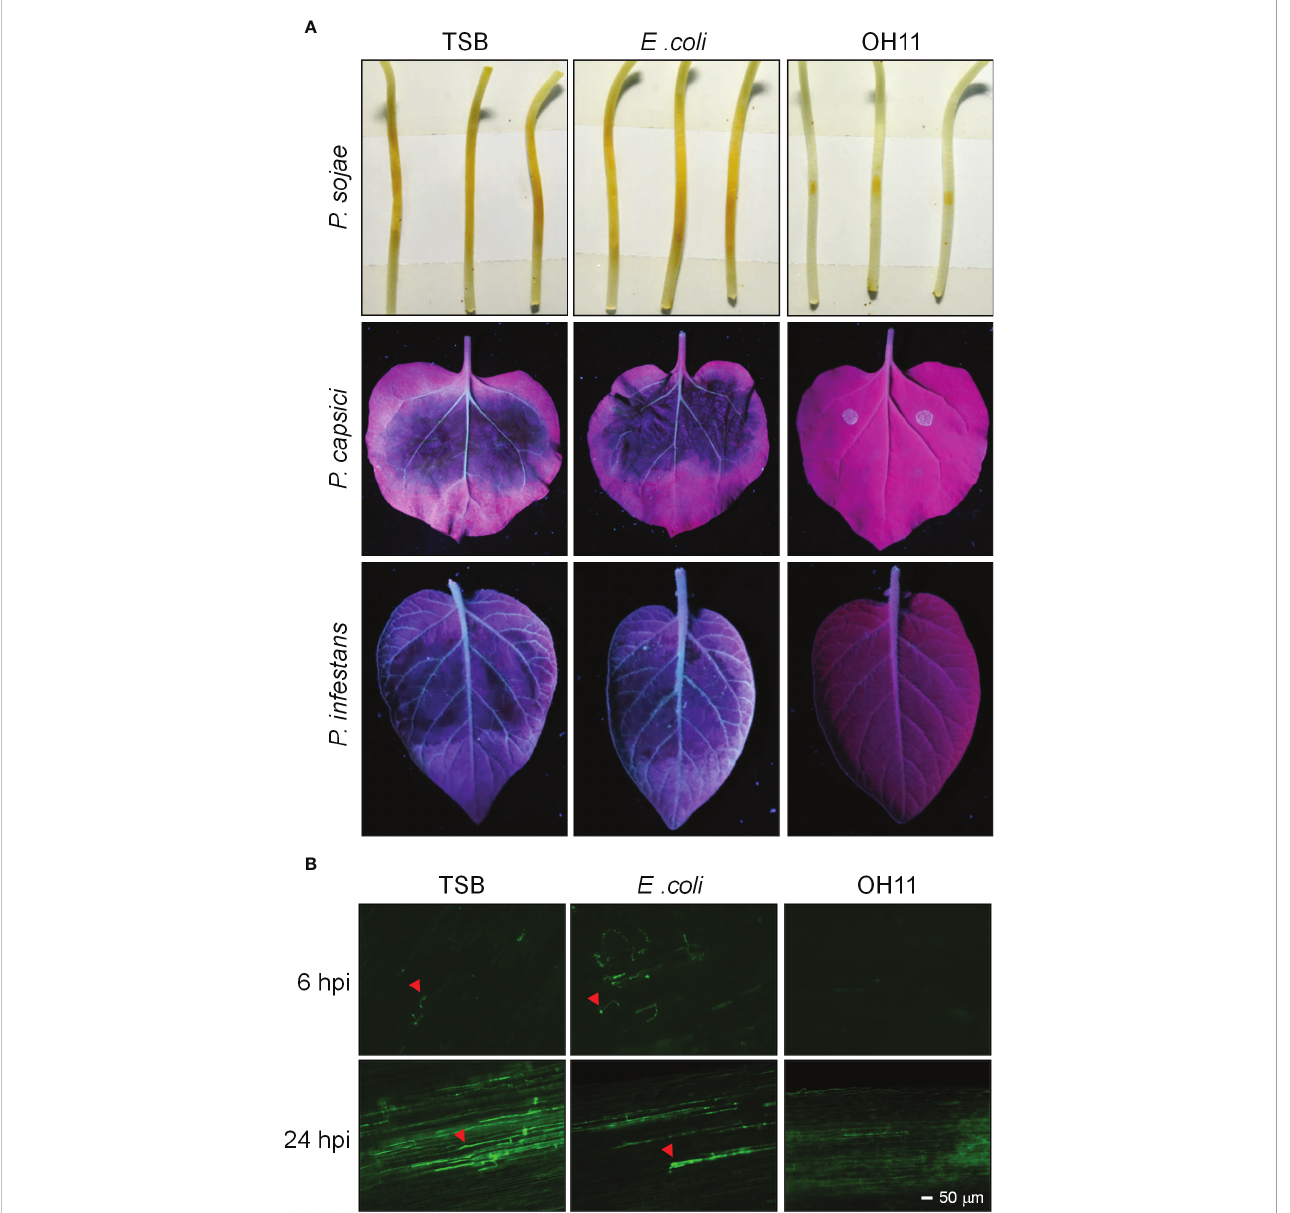
FIGURE 1 L. enzymogenes OH11 inhibited the virulence of Phytophthora . (A) OH11 inhibited the virulence of P. sojae , P. capsici and P. infestans. A total of 200 Phytophthora zoospores were mixed with an equal volume of TSB media, bacterial cultures of E coli and OH11, individually. The mixtures were inoculated onto host plants (soybean, N. benthamiana , or potato). TSB- and E. coli -treated Phytophthora had obvious lesions on host plants, while OH11- treated Phytophthora revealed no lesion. (B) OH11 inhibited infection of GFP-labeled P. sojae zoospores. At 6 hpi, TSB- and E coli -treated P. sojae showed germinated cysts that could ef fi ciently infect soybean cells, whereas OH11-treated P. sojae was not able to infect plants. At 24 hpi, TSB- or E coli -treated P. sojae infected soybean cells, whereas OH11-treated GFP-labeled P. sojae showed no invasive hyphae in soybean cells. Red arrows indicate the invasive hyphae of P. sojae